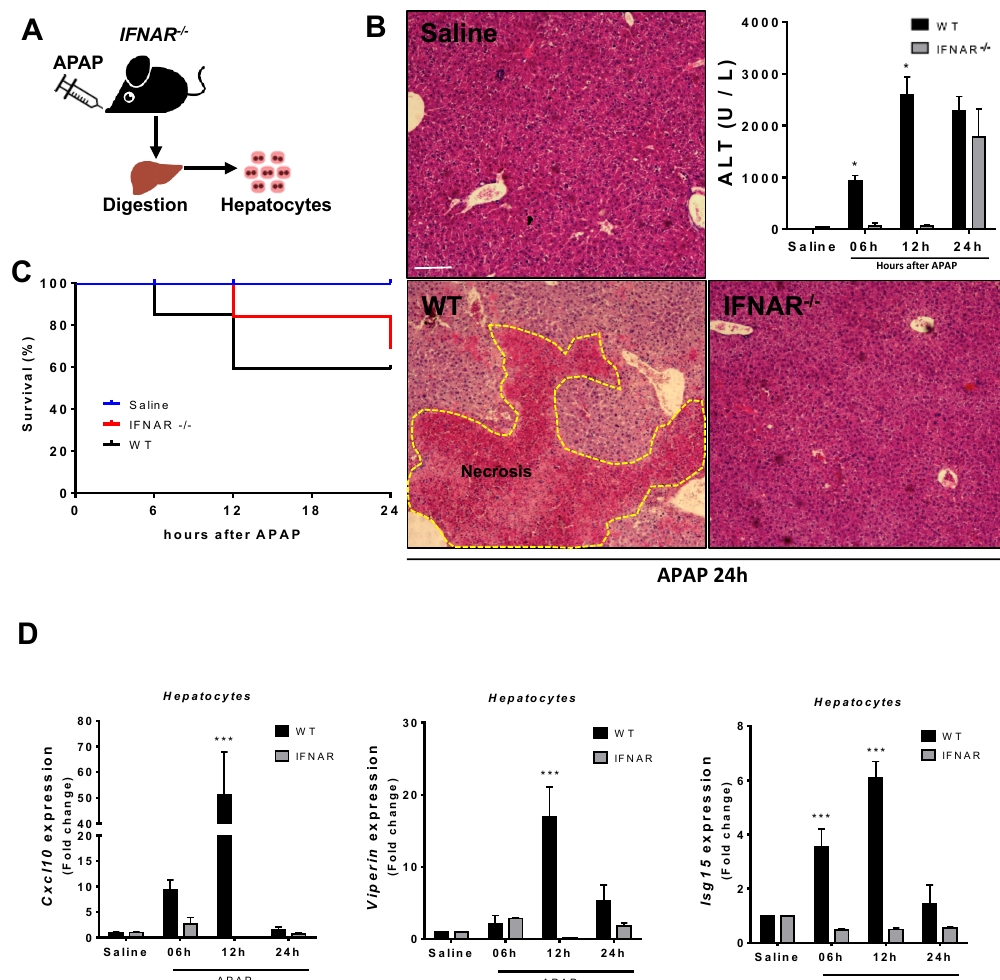
Figure 7. IFN-I production aggravates hepatic injury. ( A ) Scheme showing hepatocyte isolation from IFNAR − / − mice challenged with APAP. ( B ) Liver histology and serum ALT levels of IFNAR − / − mice 24 h after APAP (600 mg/kg) administration (HE staining). ( C ) Survival rate in IFNAR − / − mice after APAP (600 mg/kg) administration. ( D ) Expression of viperin, Isg15 and Cxcl10 in IFNAR − / − mouse hepatocytes in comparison to wild-type cells 6, 12, and 24 h after APAP administration. (Mean ± SEM; n = 5); * p ≤ 0.05 and *** p ≤ 0.001. Scale bar = 200 µ